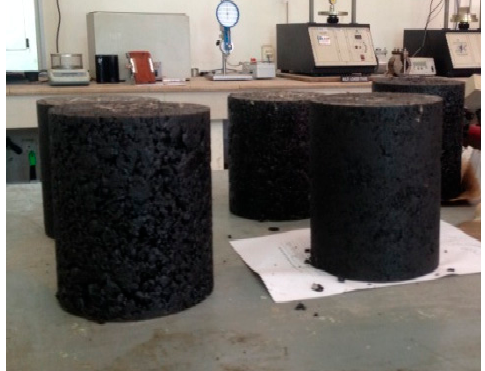
Figure 5. Specimens prepared with Gyratory Compactor.